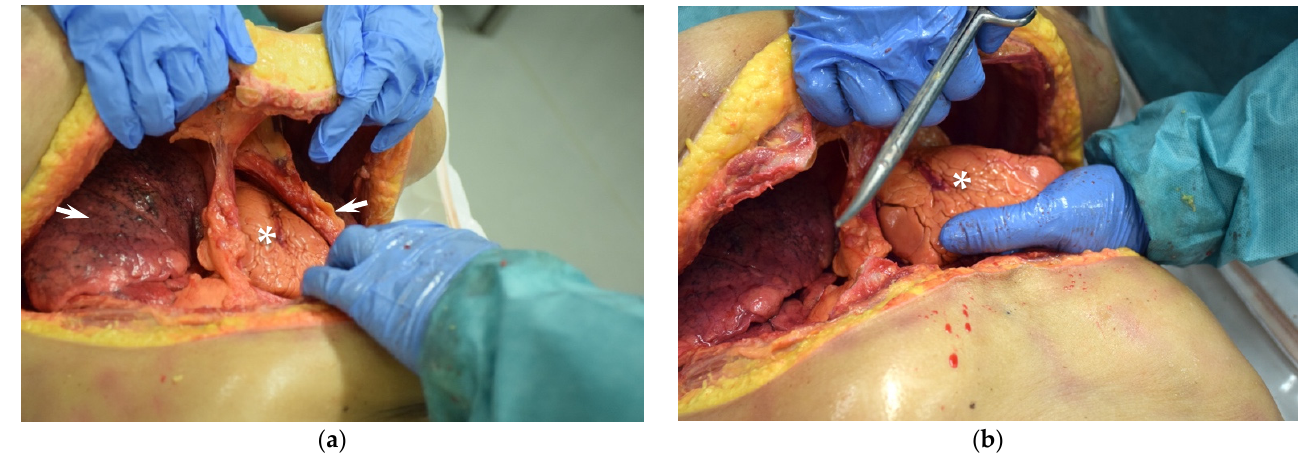
Figure 5. Clamshell thoracotomy in a cadaveric model: ( a ) Situs after thoracotomy, the chest is lifted by one rescuer to allow a good overview of the heart (asterisk) and lungs (arrowheads); ( b ) The second rescuer luxates the heart (asterisk) in order to be able to perform interventions.